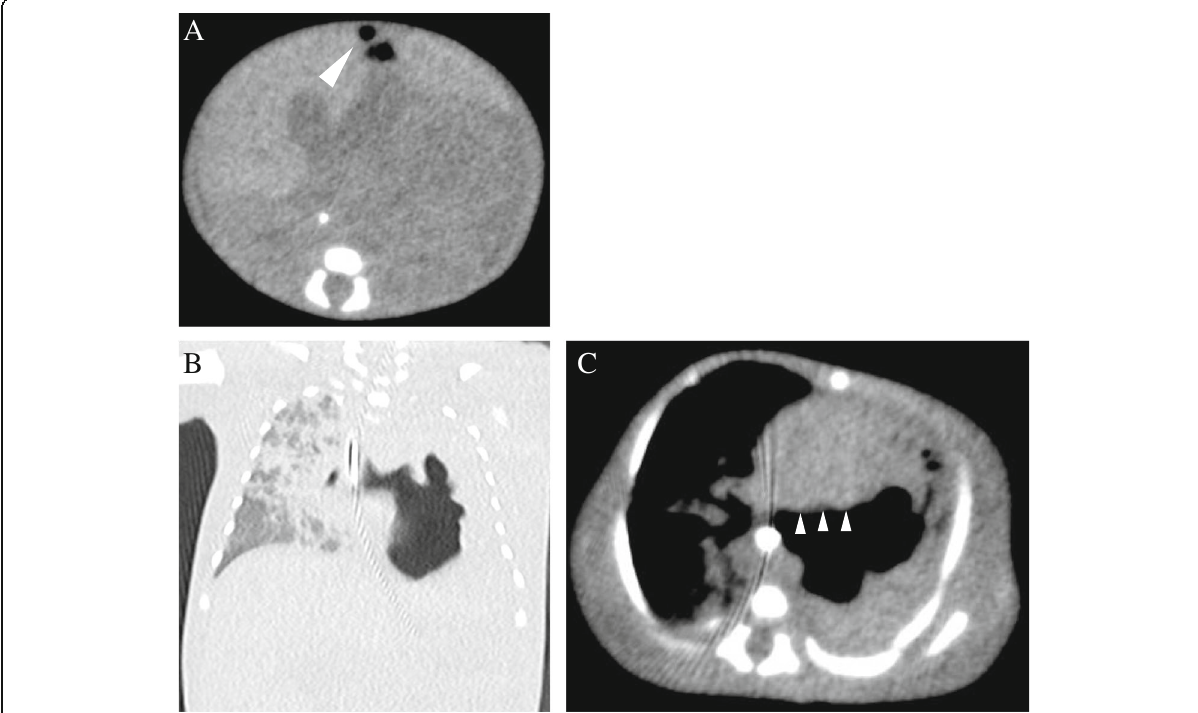
Fig. 1 Computed tomography. a Mediastinal-conditional computed tomography image showing a small amount of free air (arrowhead). b Lung- conditional computed tomography image showing a giant bulla in the left lower lung field. c Mediastinal-conditional computed tomography image showing that this bulla was compressing the extrinsic pulmonary vein and left atrium from the dorsal